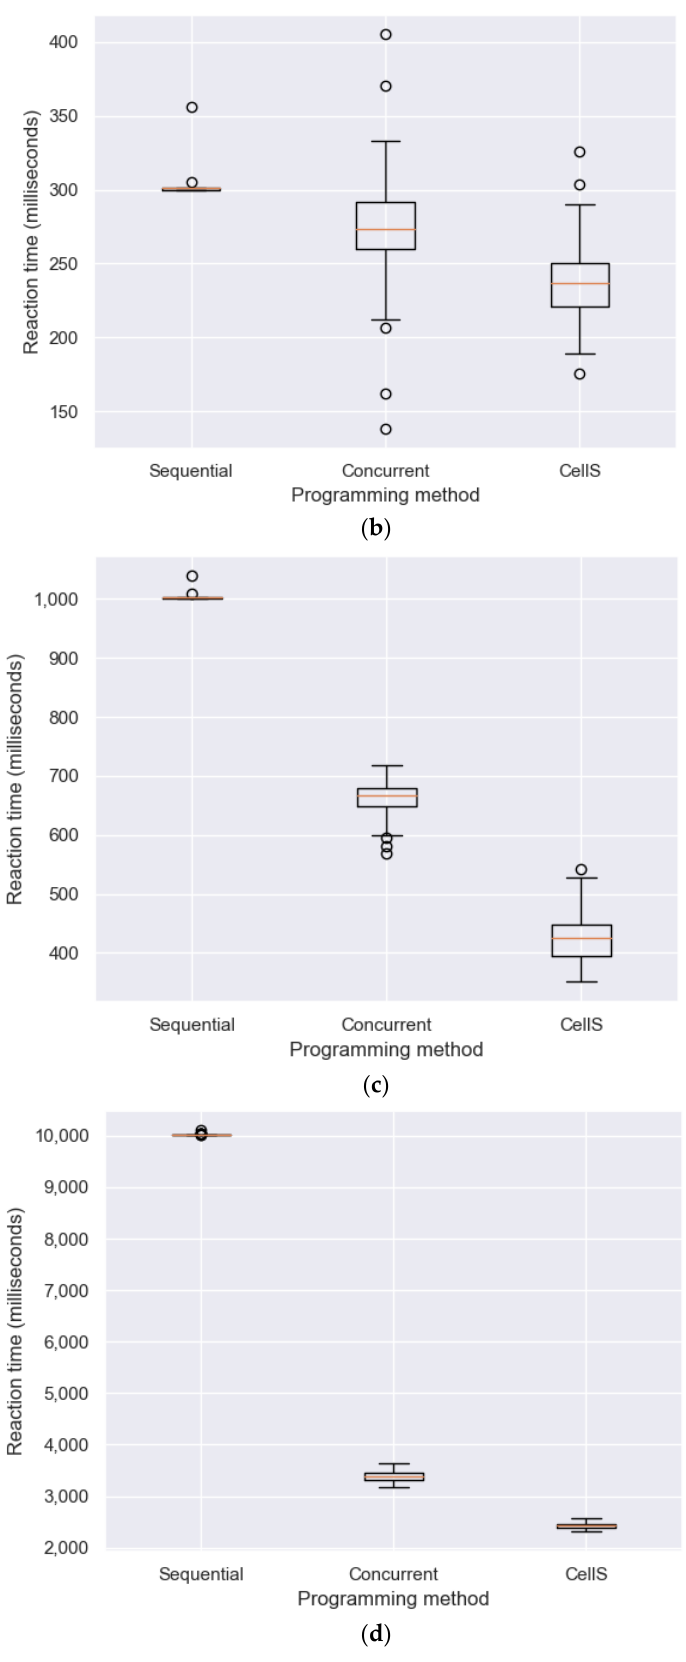
Figure 13. These are the experimental results of reaction time per round: ( a ) 10 milliseconds/flow; ( b ) 30 milliseconds/flow; ( c ) 100 milliseconds/flow; and ( d ) 1000